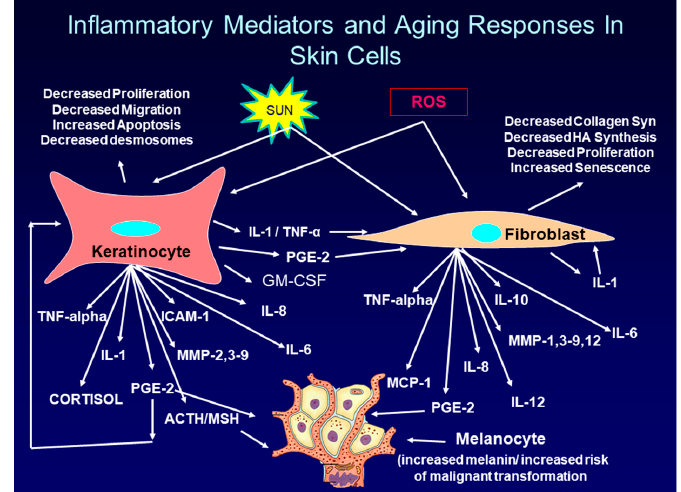
Figure 2. Paracrine and autocrine effects of PGE-2, IL-1 and TNF-alpha in producing and secreting inflammatory mediators from keratinocytes and fibroblasts in response to UVR and ROS. Certain inflammatory mediators (IL-8, TNF-alpha) cause neutrophils and monocytes (not shown) to move from the vasculature to enter the skin where they amplify the inflammatory response. Matrix Metalloproteinases (MMPs) are produced and secreted from keratinocytes, fibroblasts and immune cells migrating into the skin. The hormone, MSH (melanocyte stimulating hormone), and PGE-2 stimulate melanogenesis in melanocytes.